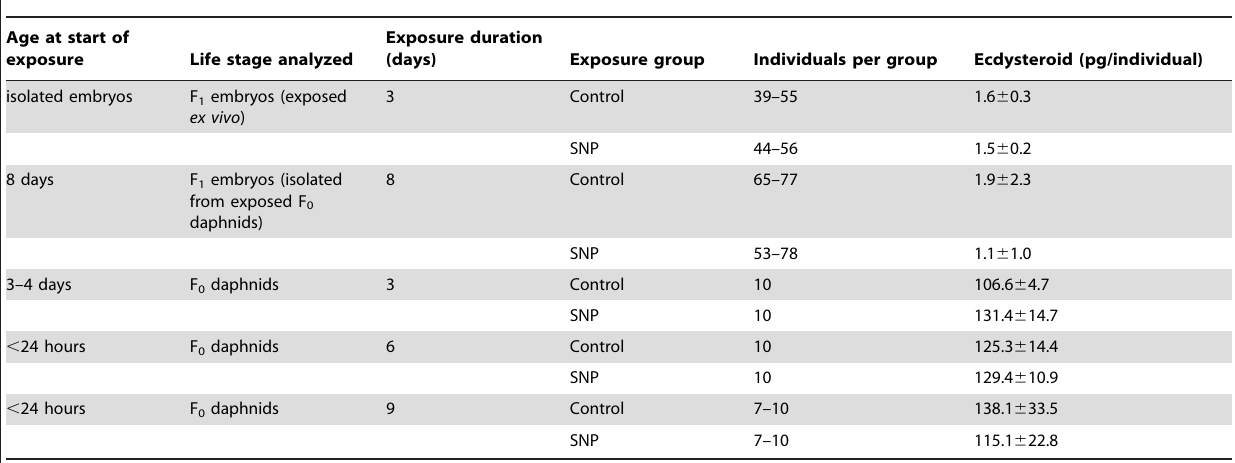
Table 1. Ecdysteroid levels in daphnids exposed to 1.0 mg N/L sodium nitroprusside (SNP).